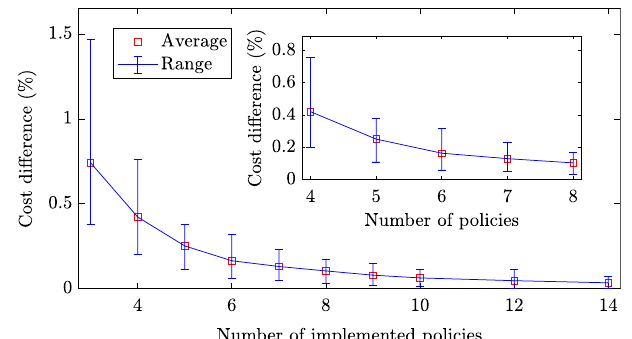
Figure 4. Additional cost from implementing a limited number of policies. Implementing a limited number of policies results in increased costs compared to the optimal continuously changing intervention strategy. This figure depicts the average and range of the percentage differences between the costs of the continuous strategies presented in Fig. 3 and strategies with a small number of policies, for different numbers of allowed distinct implemented policies. In each case, the number of allowed policy changes was twice the number of the implemented policies minus two. The boxed plot focuses on implementing between 4 and 8 distinct policies and demonstrates that 4 policies result in a cost difference of less than 1% in all